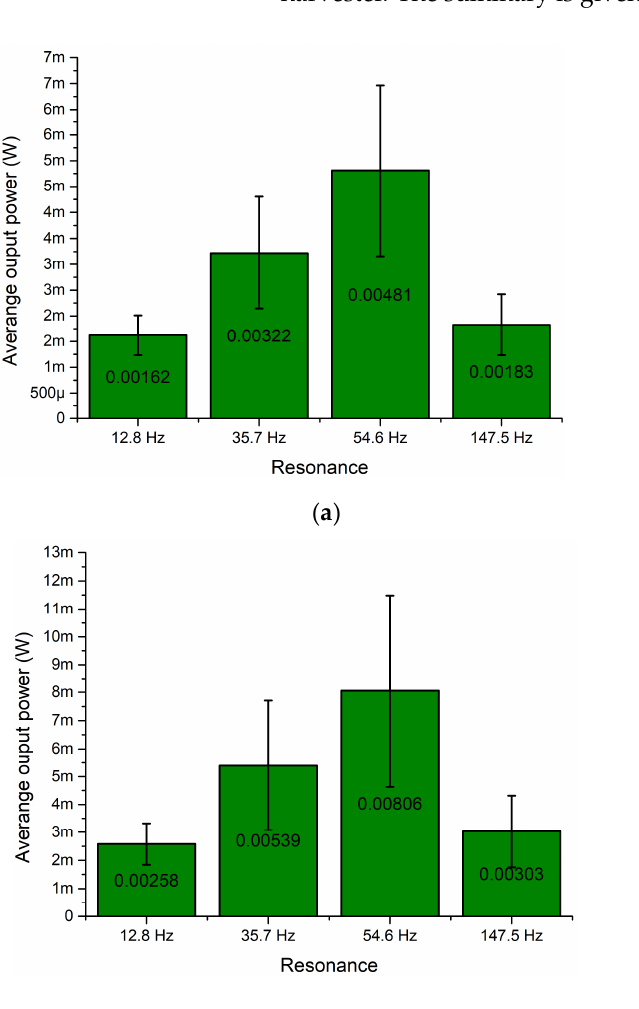
Figure 22. Frequency—power—angle of excitation motion characteristics of the energy harvester with different loads; ( a )—load equal to 1 MΩ; ( b )—load equal to 500 kΩ; ( c )—load equal to 250 kΩ.